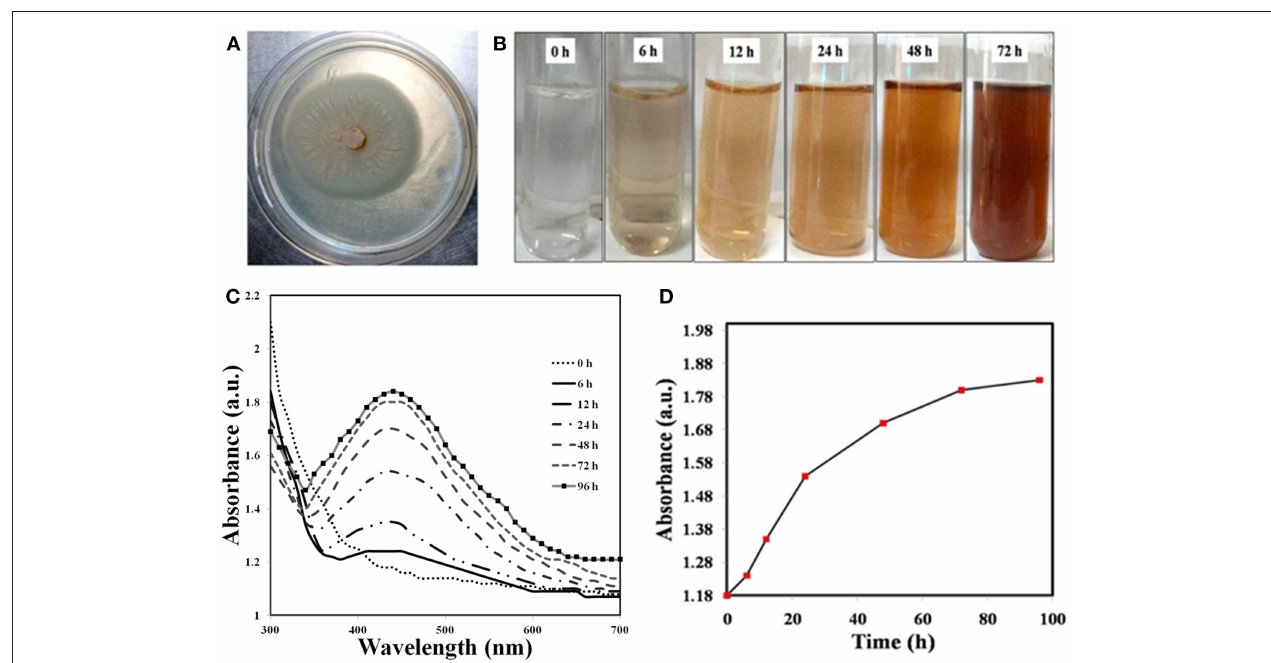
FIGURE 1 | Optical Properties. (A) Colony morphology, (B) Optical images of biosynthesized Ag NP show a range of vibrant colors from colorless (start of biosynthesis) to light brown and, finally, yellowish brown after 72h. (C) UV-vis spectra of P. indica derived Ag NPs at various reaction times; (D) Reaction saturation curve indicating the evolution of the Plasmon band as a function of